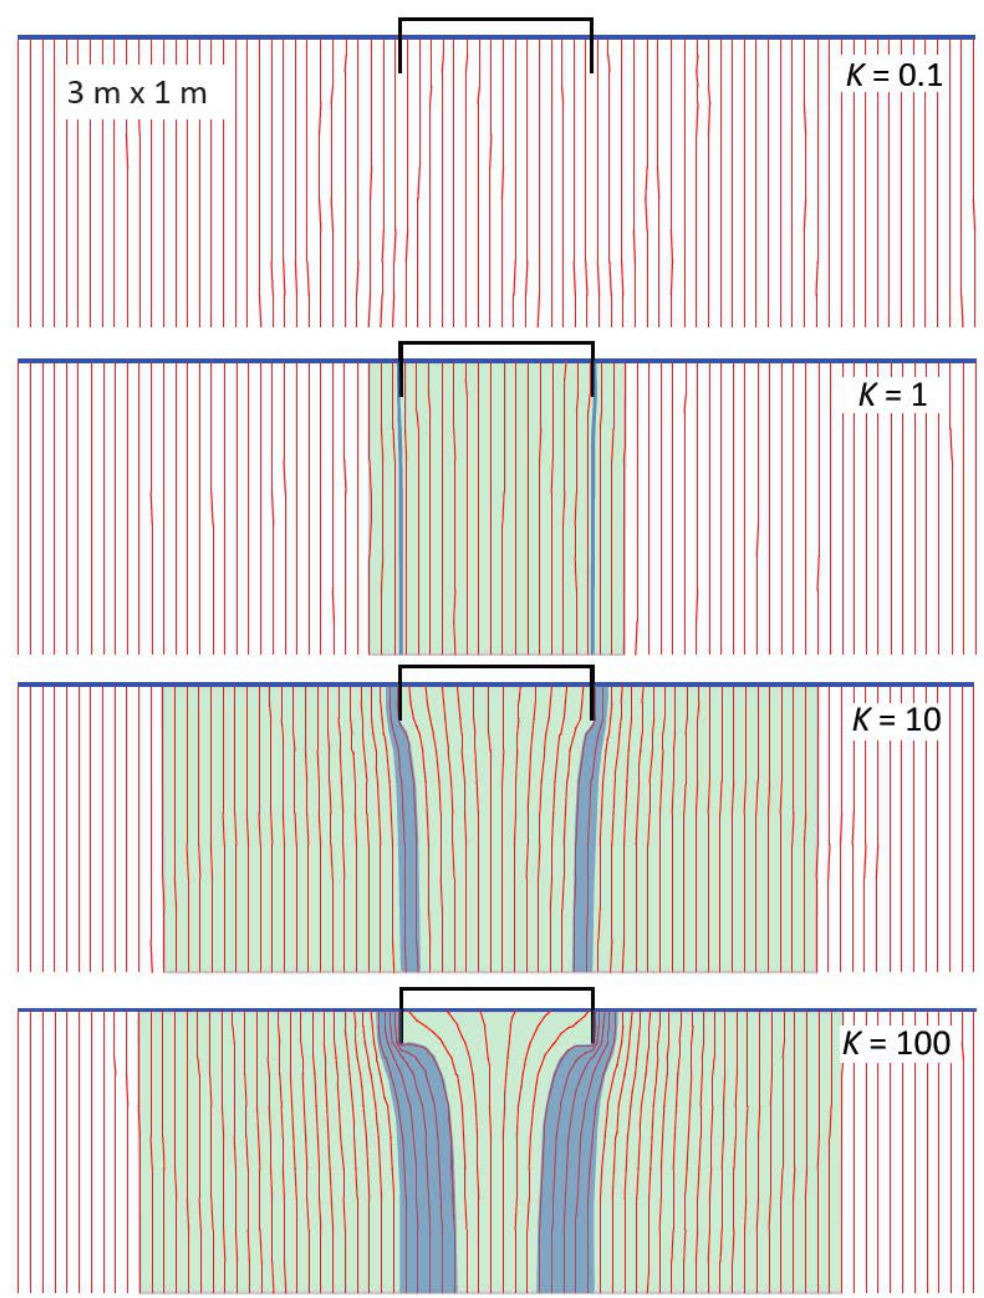
Figure 9. Deflection of flow around a simulated seepage meter inserted 0.1 m into the flow domain with a 95 percent meter e ffi ciency at K bulk = 1 m / d. Simulations shown for K bulk of 0.1, 1, 10, and 100 m / d. Red lines indicate flow paths of 80 “particles” released at the bottom of the domain. Blue shading indicates bypass flow of water that would otherwise have discharged within the simulated confines of the seepage cylinder. Green shading indicates area where otherwise vertical flow is visibly diverted laterally by the bypass flow.